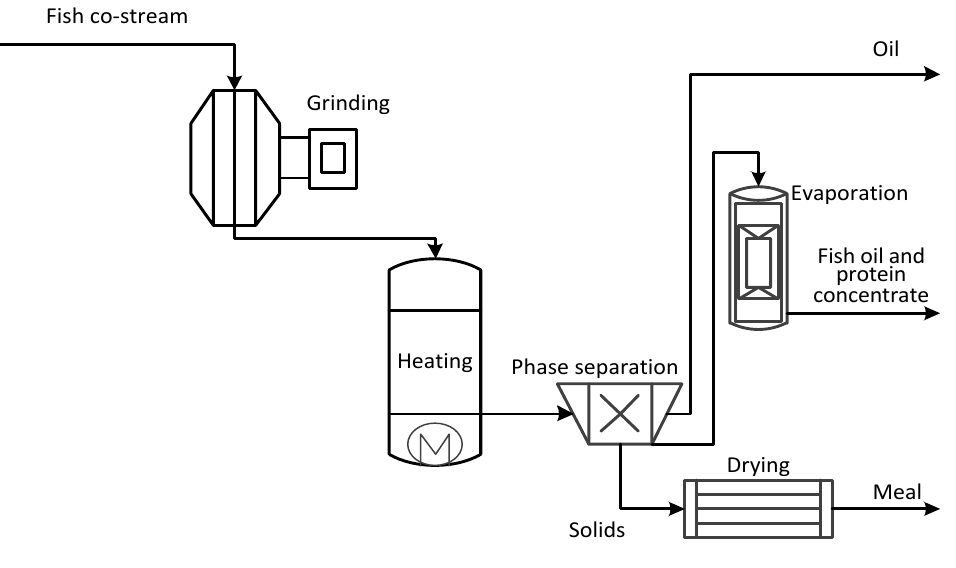
Figure 4. Production of oil and fish protein concentrate